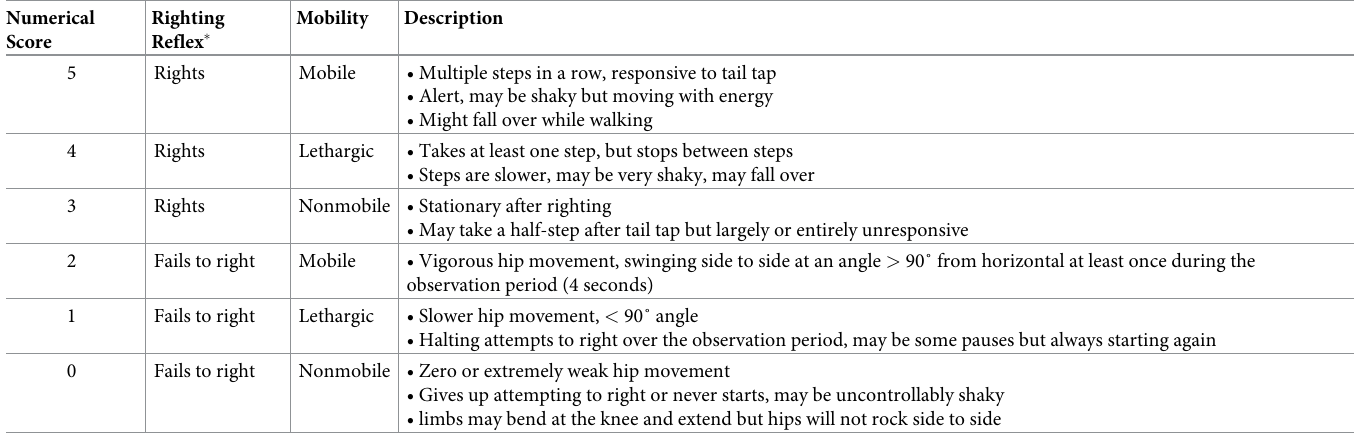
Table 1. Assigning numerical health scores to quantitative observations in neonatal